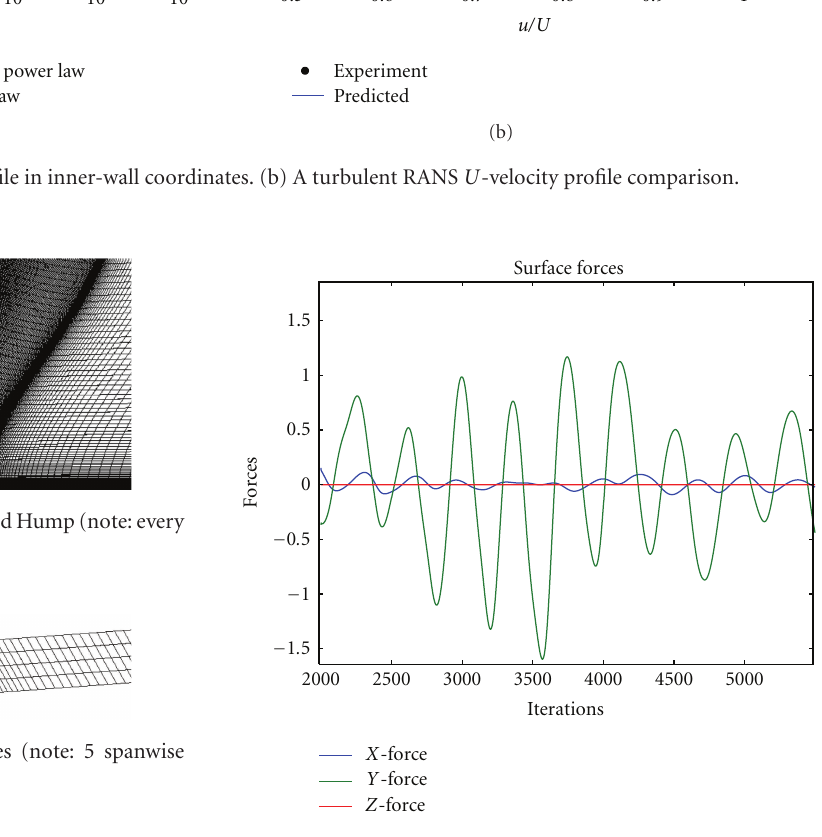
Figure 5: Lift and drag signals for three-dimensional